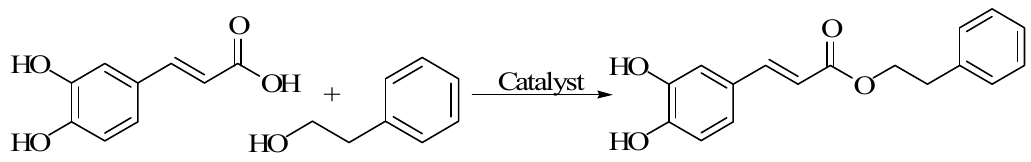
Figure 2. The scheme of direct catalysis of CAPE.